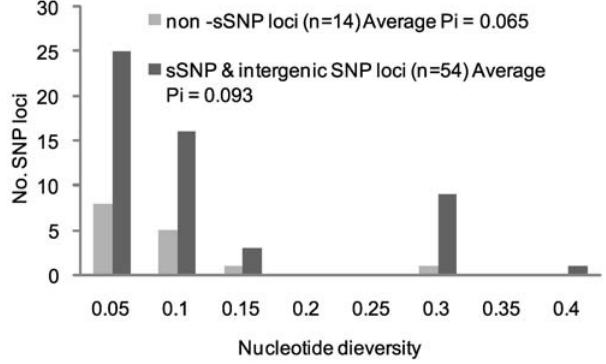
Figure 7. Nucleotide diversity among SNPs identified through genome comparison of three Ghanaian strains, for which complete SNP data have been collected in 54 Ghanaian M. ulcerans strains.